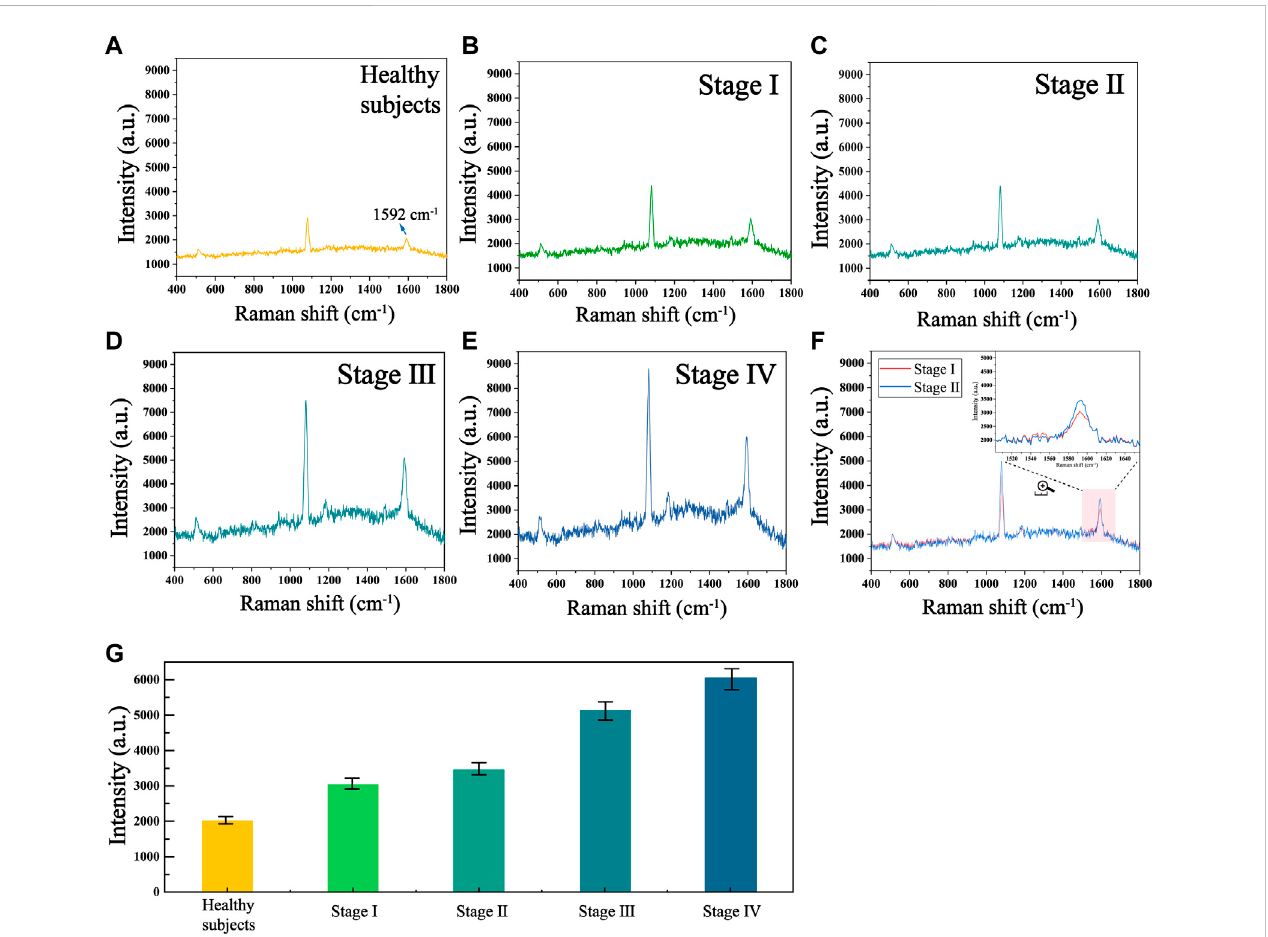
FIGURE 7 MeanSERSspectraoftelomeraseinhumanperipheralmononuclearcellsfrom (A) healthysubjectsandHCCpatientsatstages (B) I, (C) II, (D) IIIand (E) Ⅳ . (F) Mean SERS spectra at stages I and II. (G) The corresponding histogram of the Raman signal intensity at 1,592 cm − 1 .